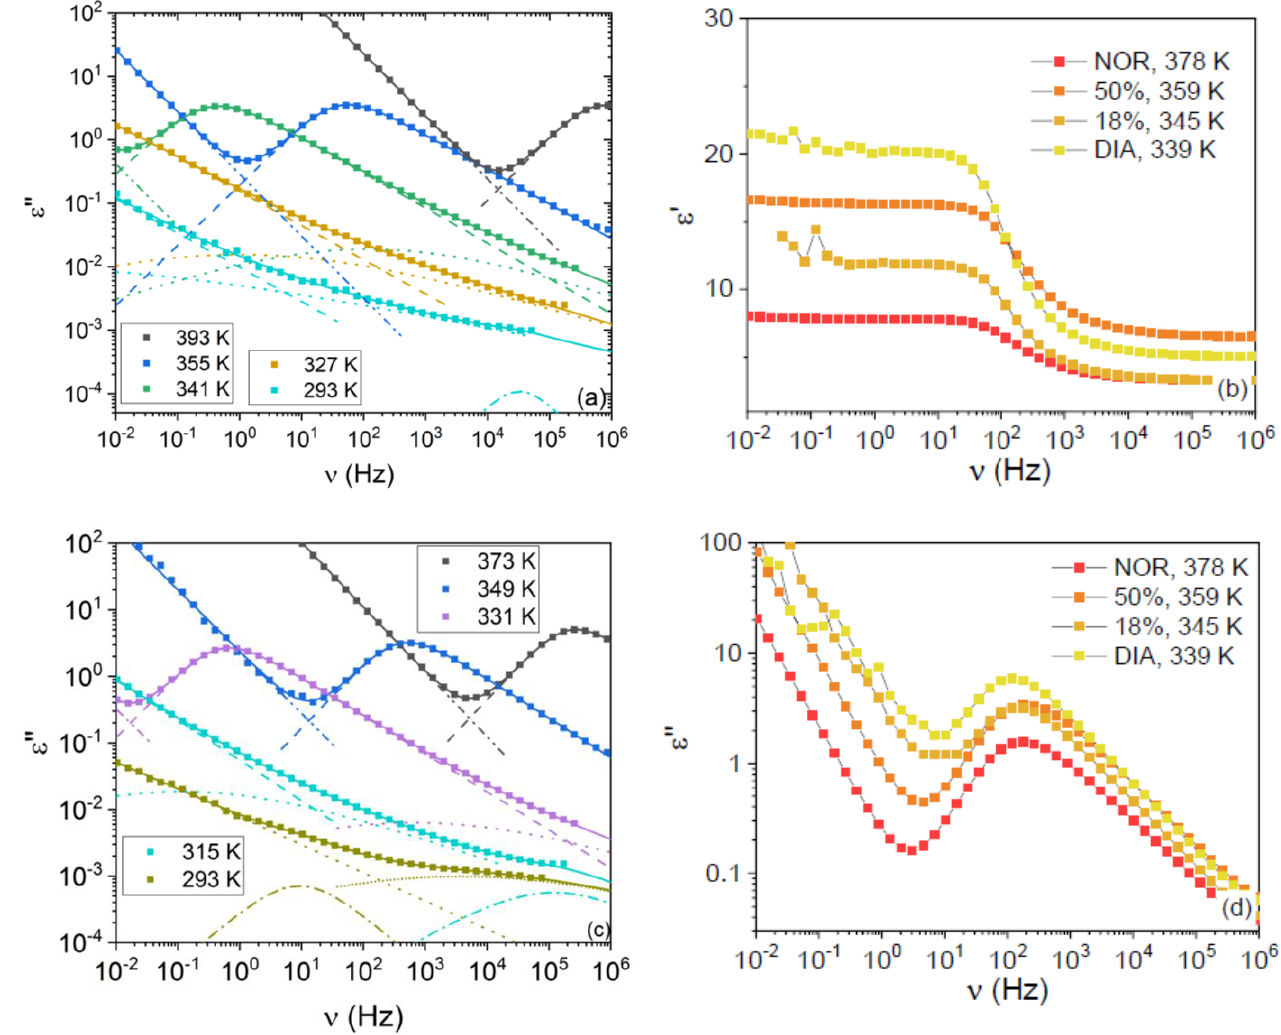
Figure 3. ( a , c ) Dielectric loss spectra of the equimolar ( a ) and eutectic ( c ) amorphous mixtures at selected temperatures. Markers are experimental points, continuous lines are fits, and dashed or dotted lines are fit components (each color represents a different temperature). ( b , d ) Real and imaginary part, respectively, of the dielectric permittivity of DIA, NOR, and binary mixtures at selected temperatures (see legend), chosen so that the relaxation time of the primary relaxation was the same in all spectra.